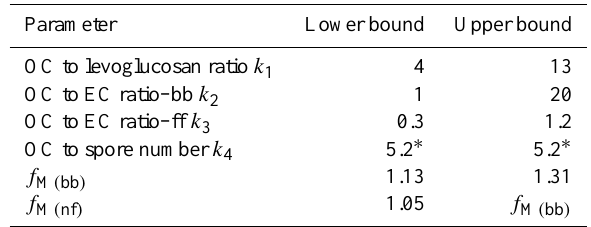
Table 2. Variability ranges of the input parameters used in the Quasi Monte Carlo